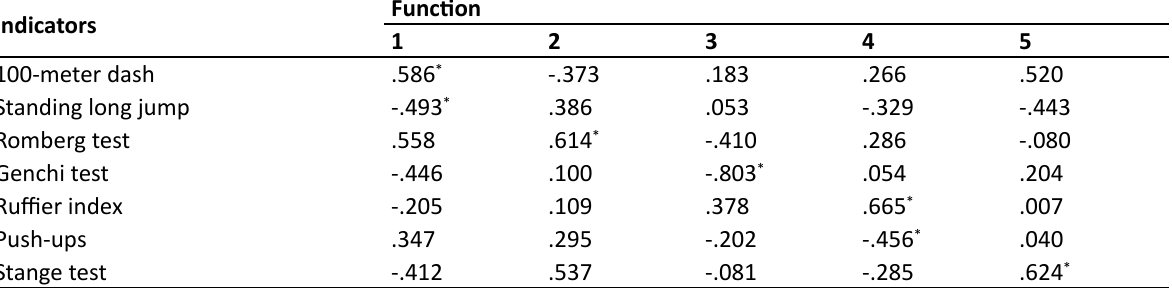
Table 7. Functions at Group Centroids